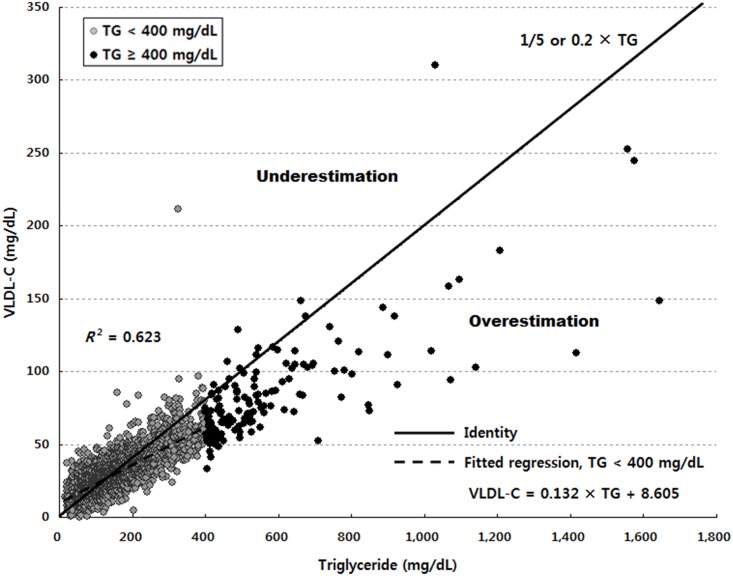
Relationship between triglyceride and very low-density lipoprotein cholesterol levels(VLDL-C indicates very low-density lipoprotein cholesterol; TG, triglyceride).The dark right-upward line represents the values of triglycerides divided by 5, the estimates of VLDL-C used in the Friedewald formula. If the true VLDL-C value is greater than the triglycerides/5 value (dots above the line), then the Friedewald equation will tend to underestimate VLDL-C, and vice versa if the true VLDL-C is less than the triglycerides/5 (dots below the line). Overall, the Friedewald formula showed a tendency to overestimate VLDL-C and thus underestimate LDL-C as triglyceride levels increased. The broken line displays the fitted regression of triglycerides on VLDL-C when triglyceride levels are lower than 400 mg/dL.